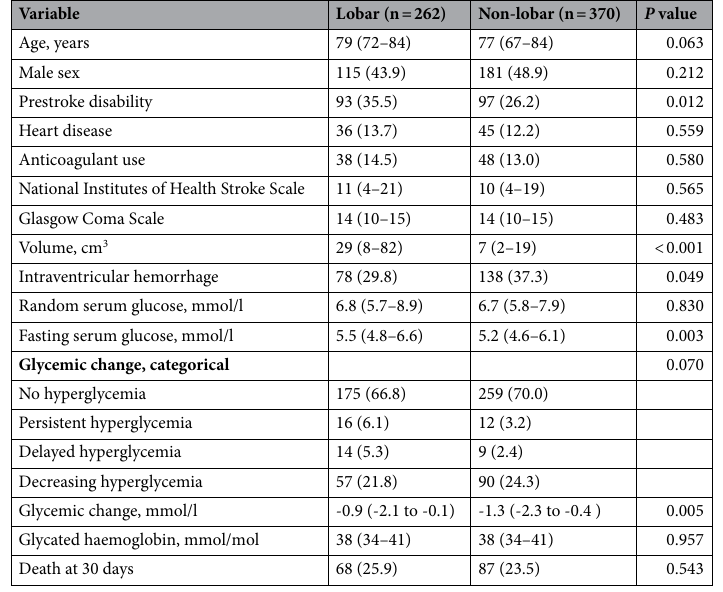
Table 1. Characteristics of the study cohort according to location of intracerebral hemorrhage. Data are median (25th–75th percentile) or n (%). To convert mmol/l to mg/dl, multiply by 18.018.